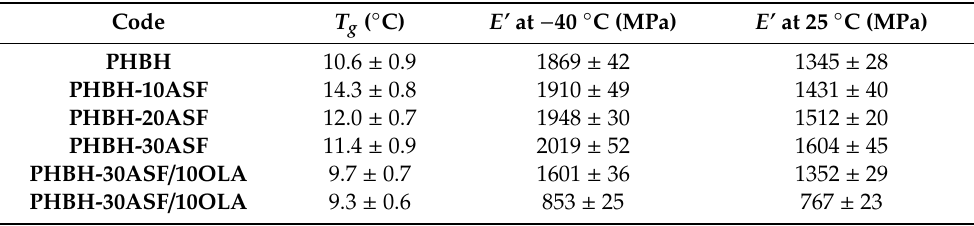
Table 5. Main dynamic-mechanical thermal parameters of PHBH-ASF / OLA composites with di ff erent compositions: flexural storage modulus ( E’ ) measured at − 40 ◦ C and 25 ◦ C and glass transition temperature ( T g ), obtained by dynamic-mechanical thermal analysis